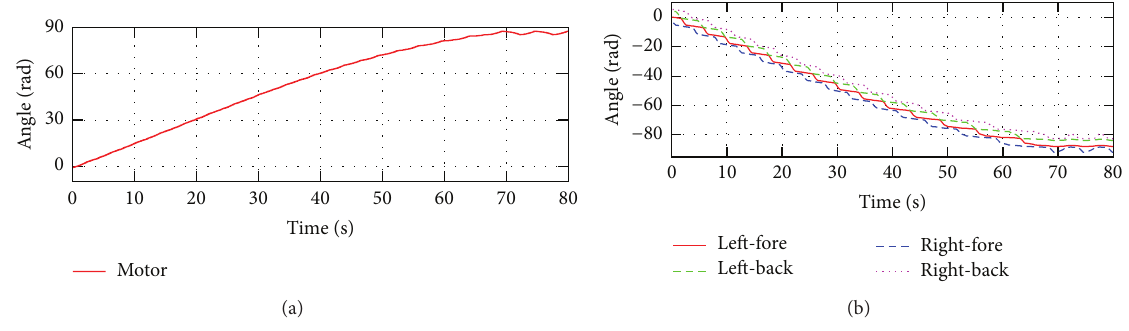
Figure 7: Time evolution of the angles of the driving gear 𝜃 𝑚 (a) and driven gears 𝜃 𝑖𝑗